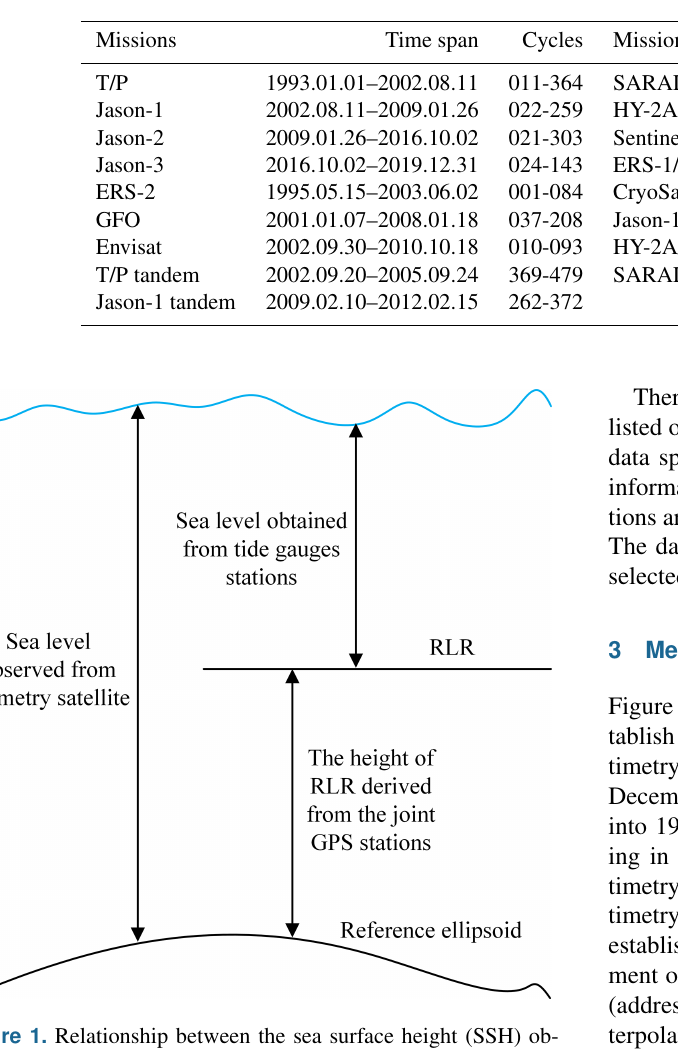
Figure 1. Relationship between the sea surface height (SSH) ob- served from the altimetry satellite, the relative SSH obtained from tide gauges above the revised local reference (RLR), and the height of RLR derived from the joint GPS stations above the reference el-